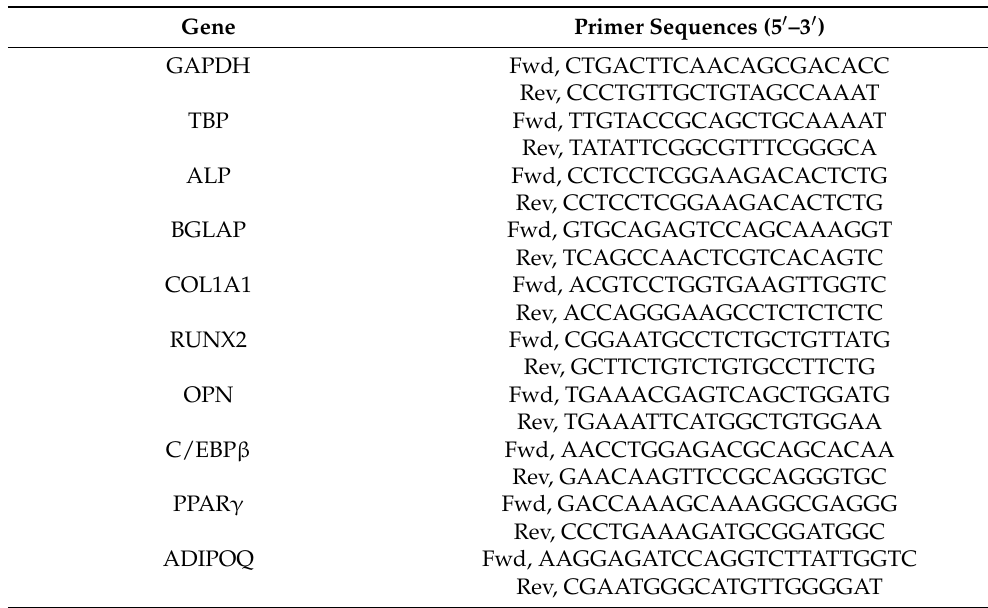
Table 1. Primer sequences for